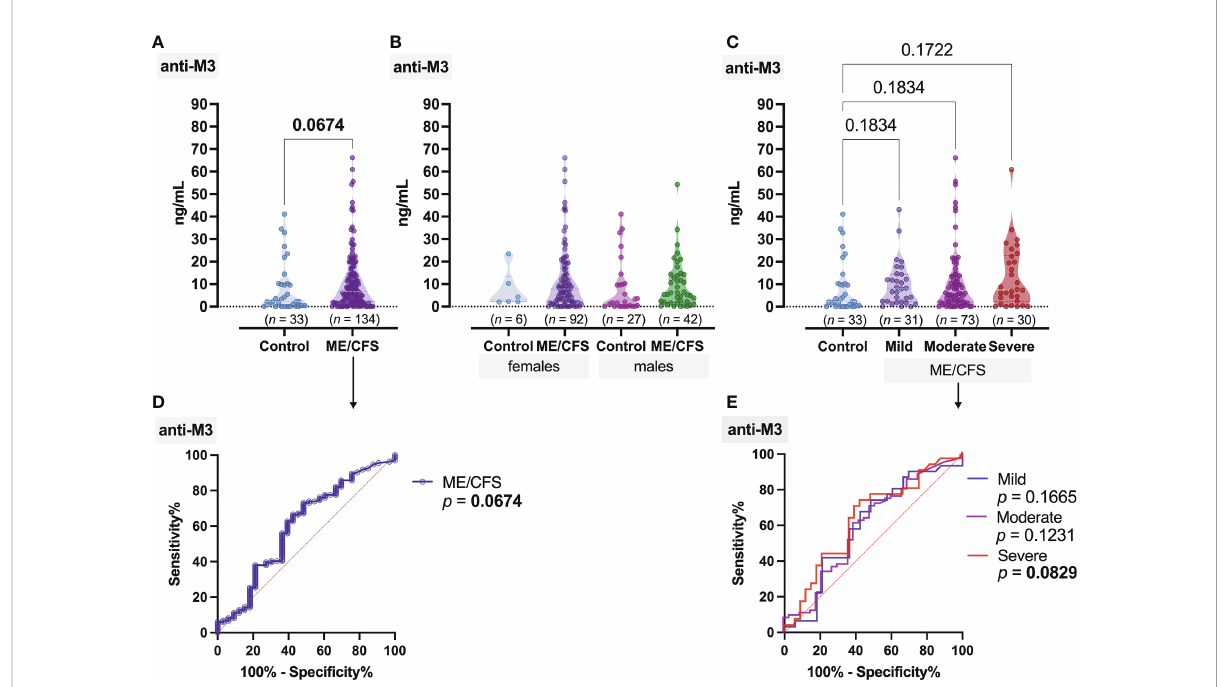
FIGURE 2 Concentration of antibodies to muscarinic cholinergic receptor 3 (anti-M3): (A) Healthy control (donors) and ME/CFS patients. (B) Regarding women and men of both groups. (C) Regarding ME/CFS severity; numbers above graphs show p -value, determined by Mann – Whitney test (A) or Kruskal – Wallis test with respective post-test (B, C) . (D, E) ROC analysis showing the potential of anti-M3 as a discriminating marker for